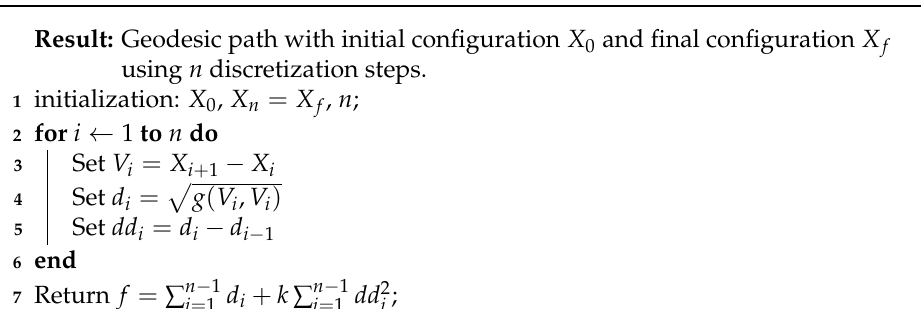
Algorithm 1: geodesic algorithm.